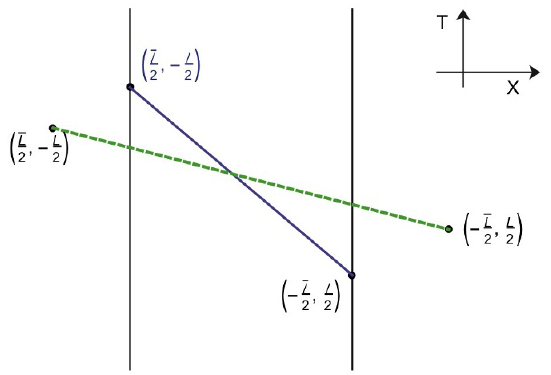
Figure 7 . The interval setup D considered in [21] which shows the domain covered by the coor- dinates ( t; x ) relative to ( T; X ). We implement this plot to construct the structure of kinematic space for